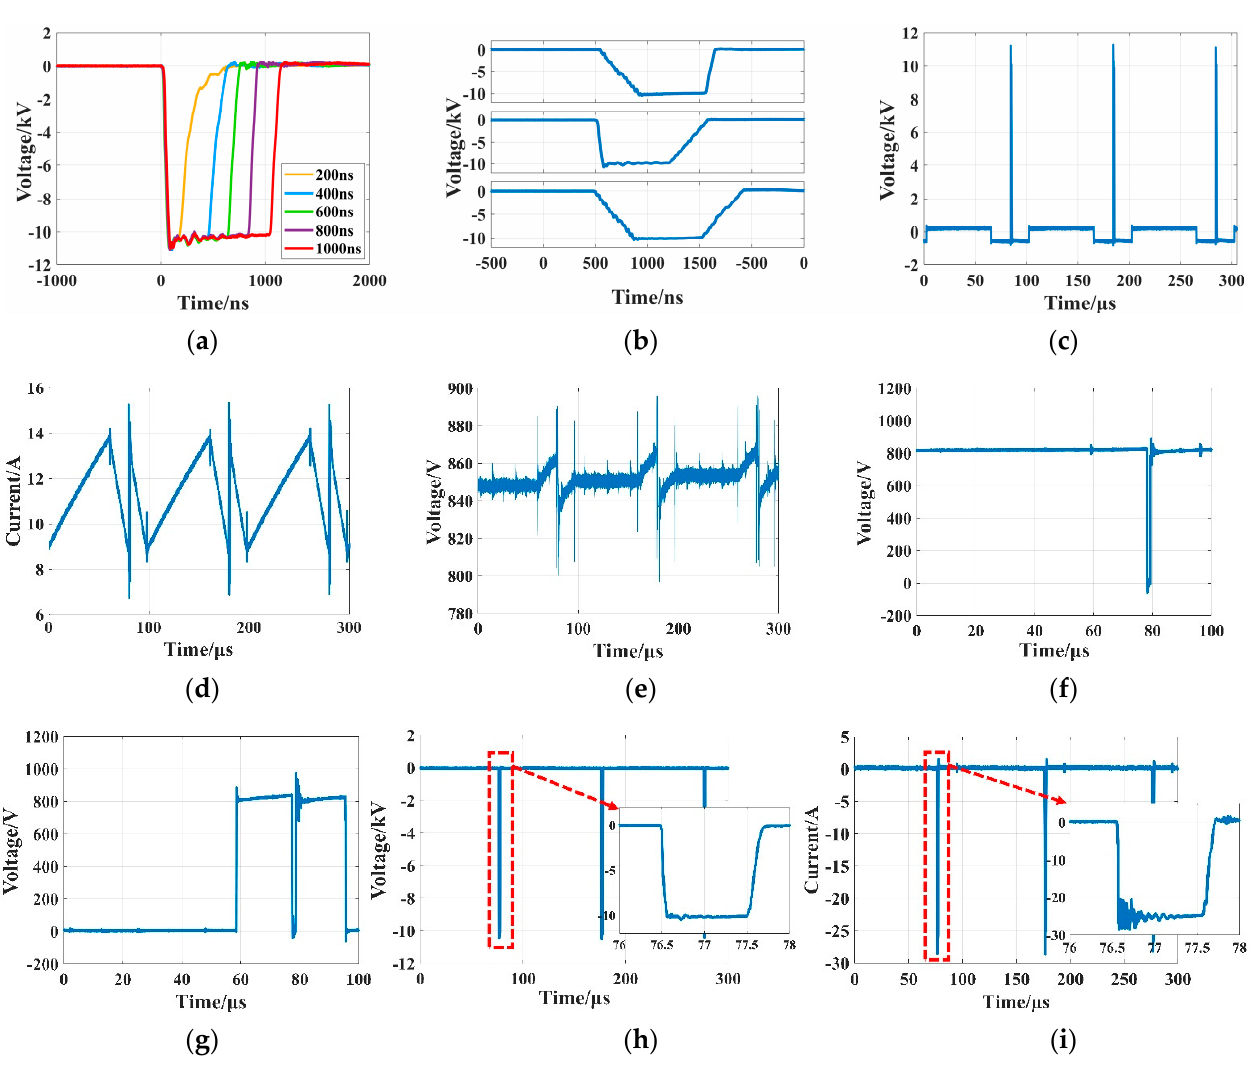
Figure 11. Experiment results of BMPG circuit (pulse frequency 10 kHz, amplitude 10 kV) ( a ) Pulse waveforms with different pulse widths ( b ) Pulse waveforms with different rising and falling time ( c ) Inductor voltage waveform ( d ) Inductor current waveform ( e ) Capacitance Voltage waveform ( f ) Switch M 1 ~ M 12 drain-source voltage ( g ) Switch M 0 drain-source voltage ( h ) Output pulse voltage waveform ( i ) Output pulse current pulse.